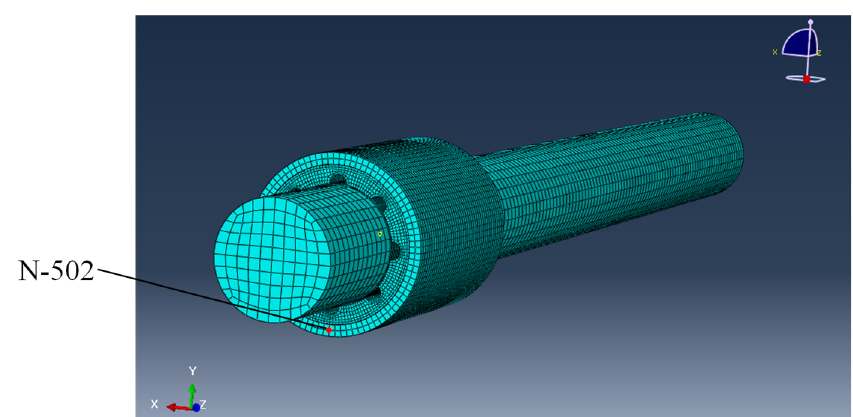
Figure 2. Geometric structure of the water-lubricated bearing.